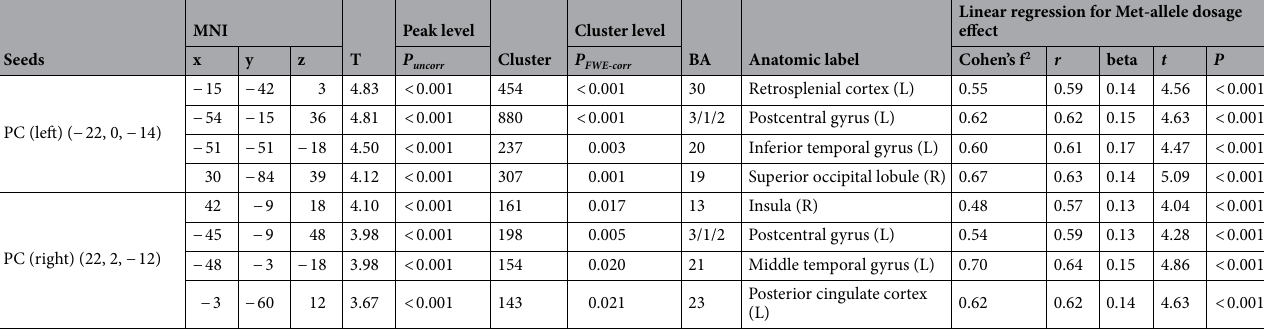
Table 1. Peak coordinates in comparison of olfactory networks in Met/Met and Val/Val groups within the olfaction cohort (n = 47). PC piriform cortex, SMA supplementary motor area, BA Brodmann area, L left, R right. Significance in linear regression was defined as P = 0.006. (0.05/8, the number of brain areas examined =